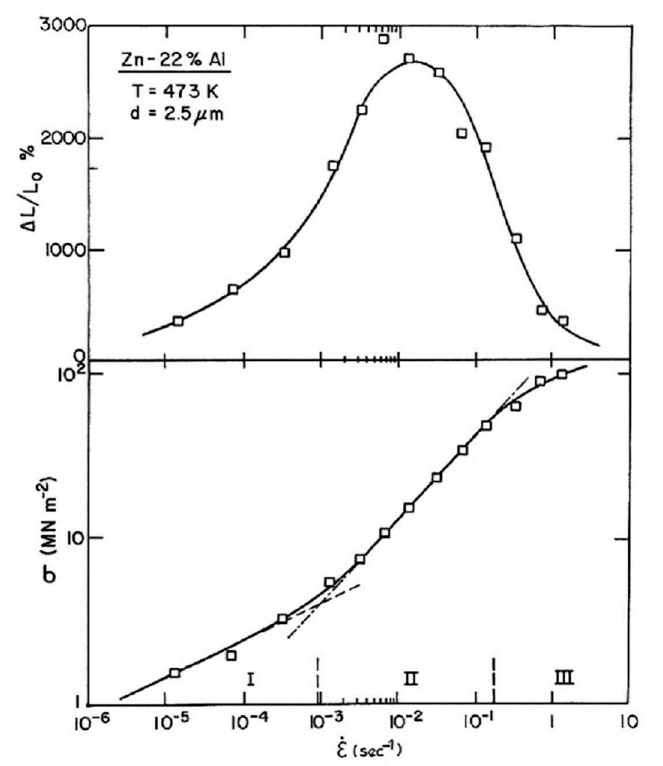
Figure 3. Elongation to failure (upper) and flow stress (lower) plotted against the imposed strain rate for samples of Zn–22% Al alloy tested in tension at 473 K [22].